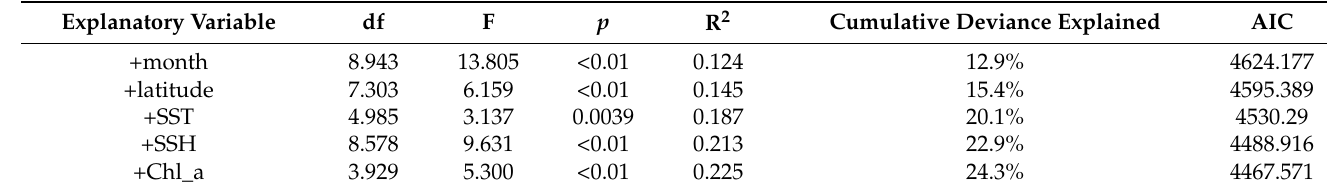
Table 2. Summary analysis of deviance for generalized additive models